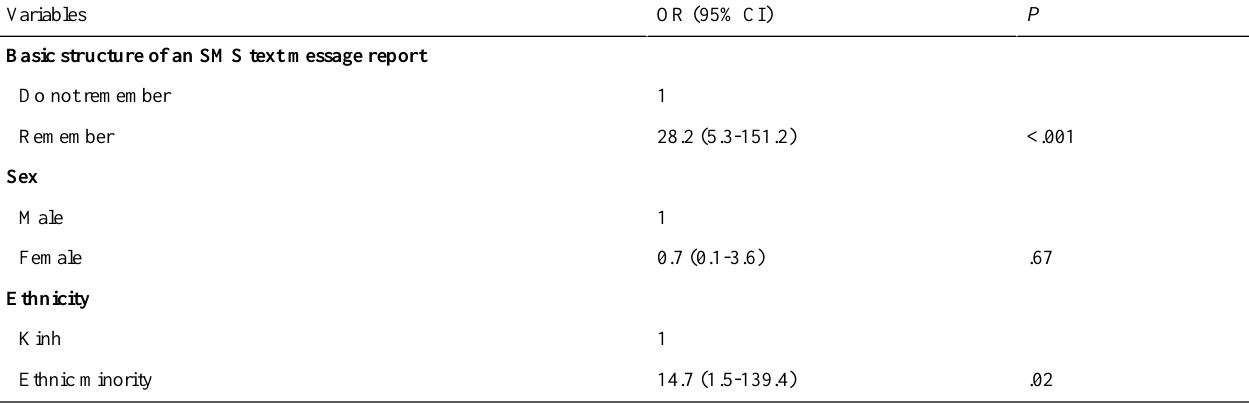
P OR (95% CI)Variables